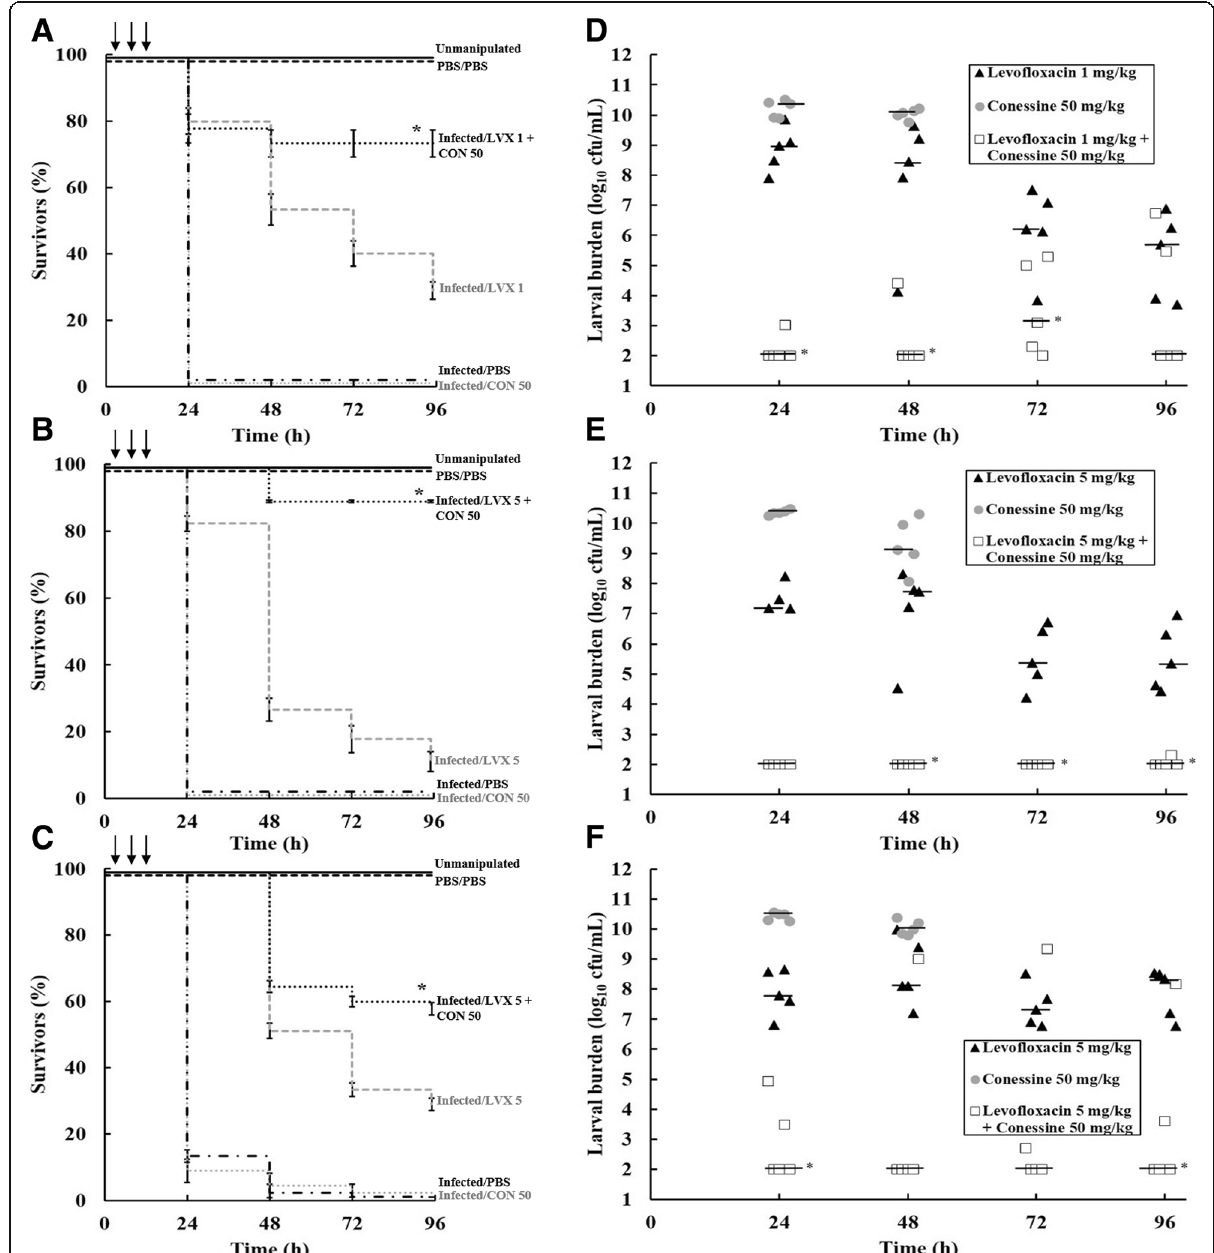
Fig. 2 Effect of treatment with combinations of conessine and levofloxacin on survival of G. mellonella larvae infected with P. aeruginosa PAM1020 ( a ), PAM1032 ( b ) and PAM1034 ( c ), or larval burden of the same strains PAM1020 ( d ), PAM1032 ( e ) and PAM1034 ( f ). All larvae were inoculated with 2.5 × 10 3 cfu/mL P. aeruginosa and treated with each agent individually or in combination with three doses at 2, 4 and 6 h post- infection (indicated by the arrows). Treatments consisted of PBS, conessine (50 mg/kg), levofloxacin (1 or 5 mg/kg, indicated on graph), and a combination of conessine with levofloxacin. Larvae were incubated at 37 °C for 96 h and survival recorded every 24 h. The burden of P. aeruginosa was determined from five individual larvae every 24 h. For clarity, data for treatment with PBS alone is not shown because the data obtained was similar to that obtained for conessine treatment alone. * a ), b ) and c ); combination treatment group with significantly enhanced survival compared with any of the constituent monotherapies ( P < 0.05, log-rank test with Holm ’ s correction for multiple comparisons). n = 45 (pooled from triplicate experiments). Error bars indicate ±SEM. LVX, levofloxacin; CON, conessine. * d ), e ) and f ); significant difference in larval burden between groups treated with the combination of conessine and levofloxacin compared with the constituent monotherapies; n = 5 ( P < 0.05, the Mann – Whitney U -test compared the combination therapy with each monotherapy individually). The black bar represents the median value of larval burden per